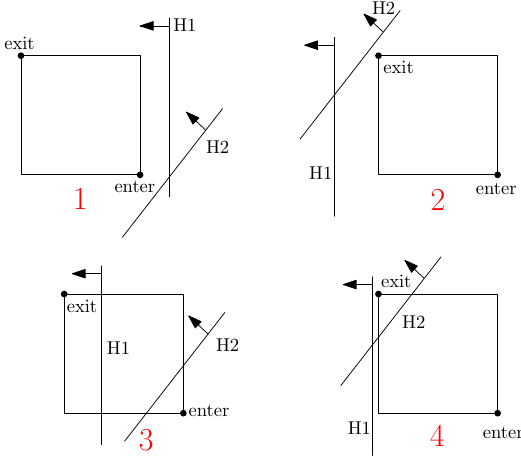
Figure 6. Four cases of intersection between a SFC node and half-spaces in the 2D